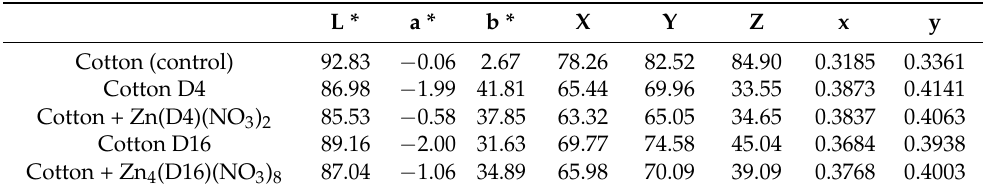
Table 1. The color characteristics of non-treated cotton fabric and cotton treated with dendrimers and metallodendrimers.